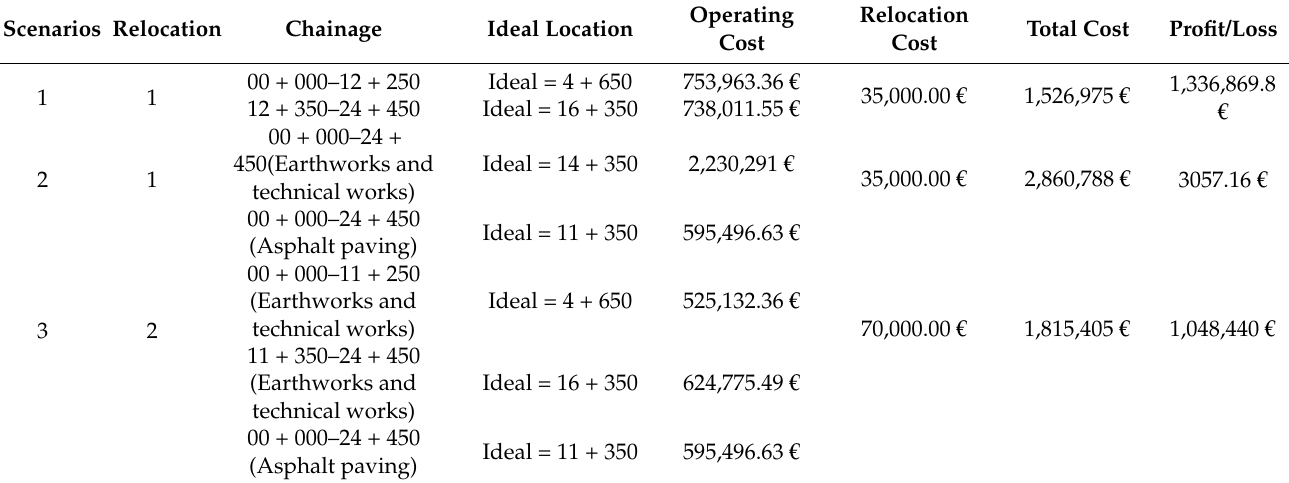
Table 9. Profit gained in operating costs by changing the construction method in the third